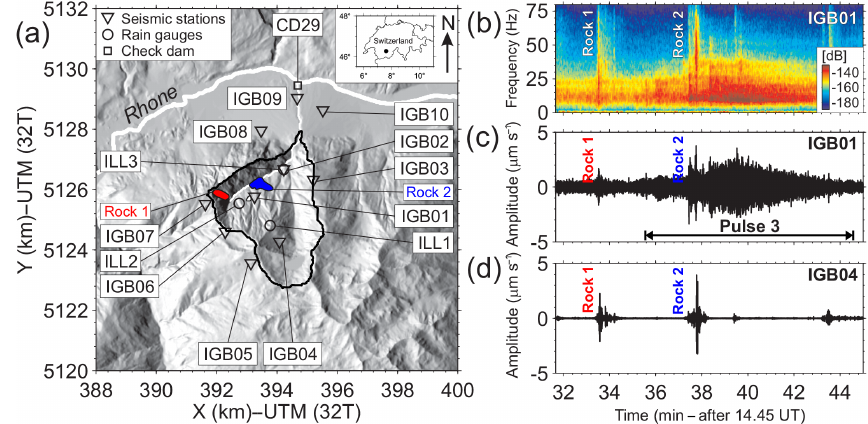
Figure 10. (a) The Illgraben catchment ( ∼ 10km 2 , outlined in black) in Switzerland (dot in the inset map) and location of the seismological stations deployed during summer 2011 (inverse triangles, labels IGB##), meteorological stations from the Swiss Federal Institute for Forest, Snow and Landscape Research WSL (circles, labels ILL#), and Check Dam 29 (CD29, square) where the flow depth and bedload impact rates are measured. Rock 1 and 2 are the two rockfalls related with the debris-flow sequence. (b) Spectrogram in decibels of the vertical seismic signal at station IGB01 during the flow pulse 3. (c, d) Vertical [1–50]Hz bandpass-filtered seismograms at stations IGB01 (c) and IGB04 (d) . The signals of both rockfalls (Rock 1 and 2) are highlighted. After Burtin et al.